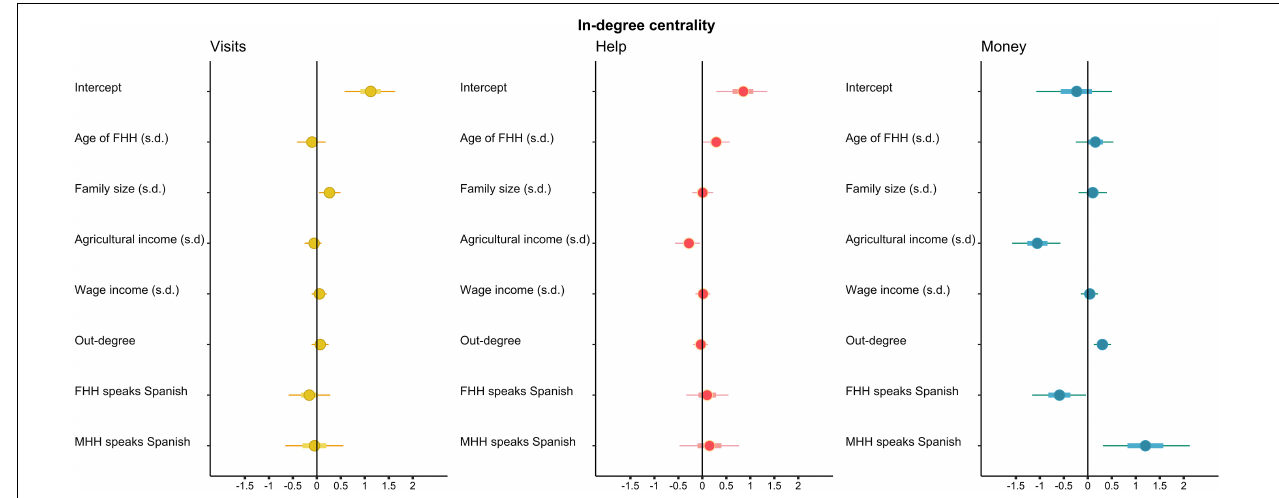
FIGURE 6 | Posterior distributions of coefficients for the selected predictor variables for households’ in-degree centrality in the visiting network (left) , helping network (middle) , and money-lending network (right) . Points show median in-degree centrality, thick lines are 50% HPDIs, and thin lines are 90% HPDIs. A vertical line represents no effect. All continuous variables were standardized. The variables, top to bottom, refer to the number of hectares under cultivation available to the family, the size of the family, the age of the female household head (FHH) (SD), whether the male head of the household engaged in wage labor, out-degree, whether the female head of the household was a Spanish speaker and whether the male head of the household was a Spanish speaker. Note that as the visit network was drawn by women reporting their “out-degree,” in this network “in-degree” reflects the visits received by a household only from the female heads of other households. On the contrary, in-degree across the other two networks reflects help and money that households could obtain from any (member of any) other